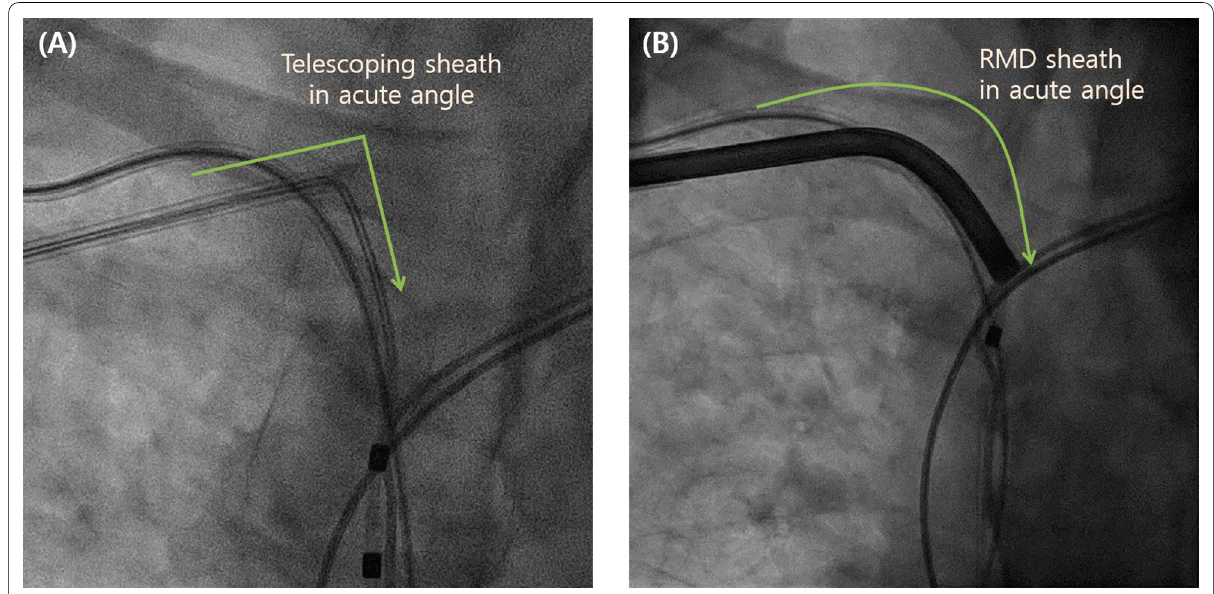
Fig. 2 Right‑sided approach for lead extraction. The stiff shaft of the telescoping sheath is easy to buckle when used in the right‑sided approach due to acute course of the lead ( A ). In contrast, the RMD sheath with more flexible shaft can follow the lead more effectively, staying coaxial to the targeted lead ( B )